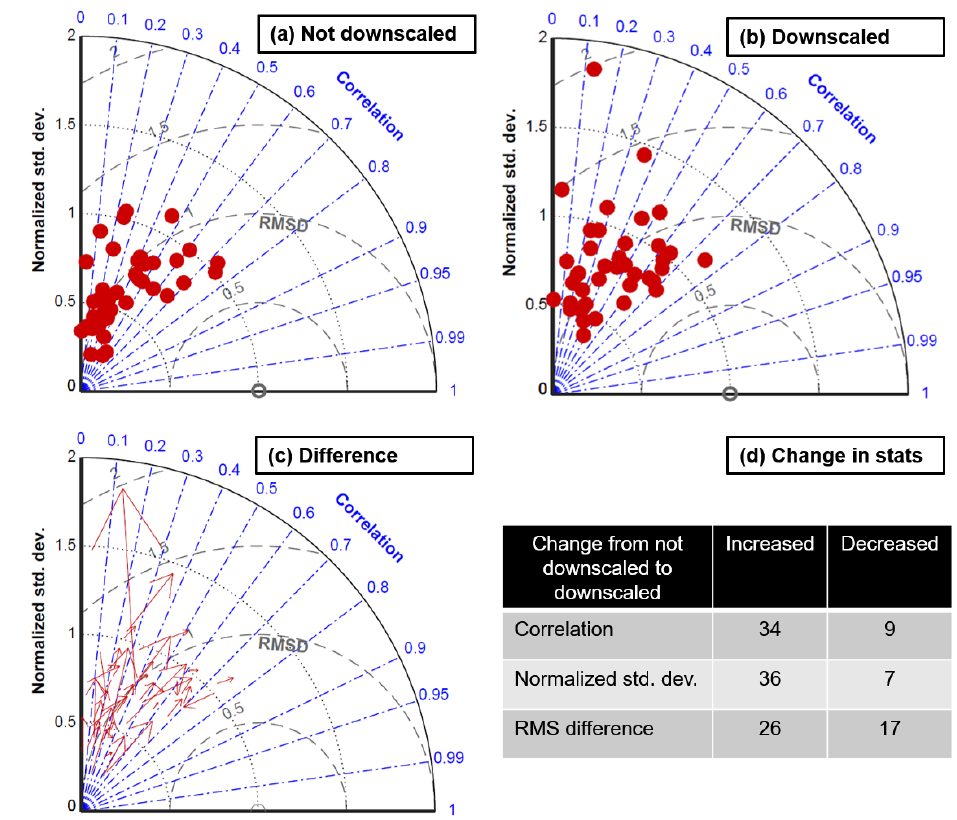
Figure 8. ( a ) Taylor diagram with red circles indicating the correlation and standard deviation of not downscaled (mascon) GRACE OBP with OBP from in situ BPRs, 3–12 month timescales, positive correlations only. The standard deviations were normalized by the in situ BPR standard deviations as in Figure 7. ( b ) Same as ( a ) but for the downscaled GRACE OBP values. ( c ) Diagram showing the difference (change) in correlation and normalized standard deviation due to the downscaling; the red vectors indicate the difference between not downscaled and downscaled values, pointing to the downscaled values. ( d ) Table indicating how many sites had an increase/decrease in correlation, normalized std. dev., and RMS difference with in situ OBP time series (among 43 total